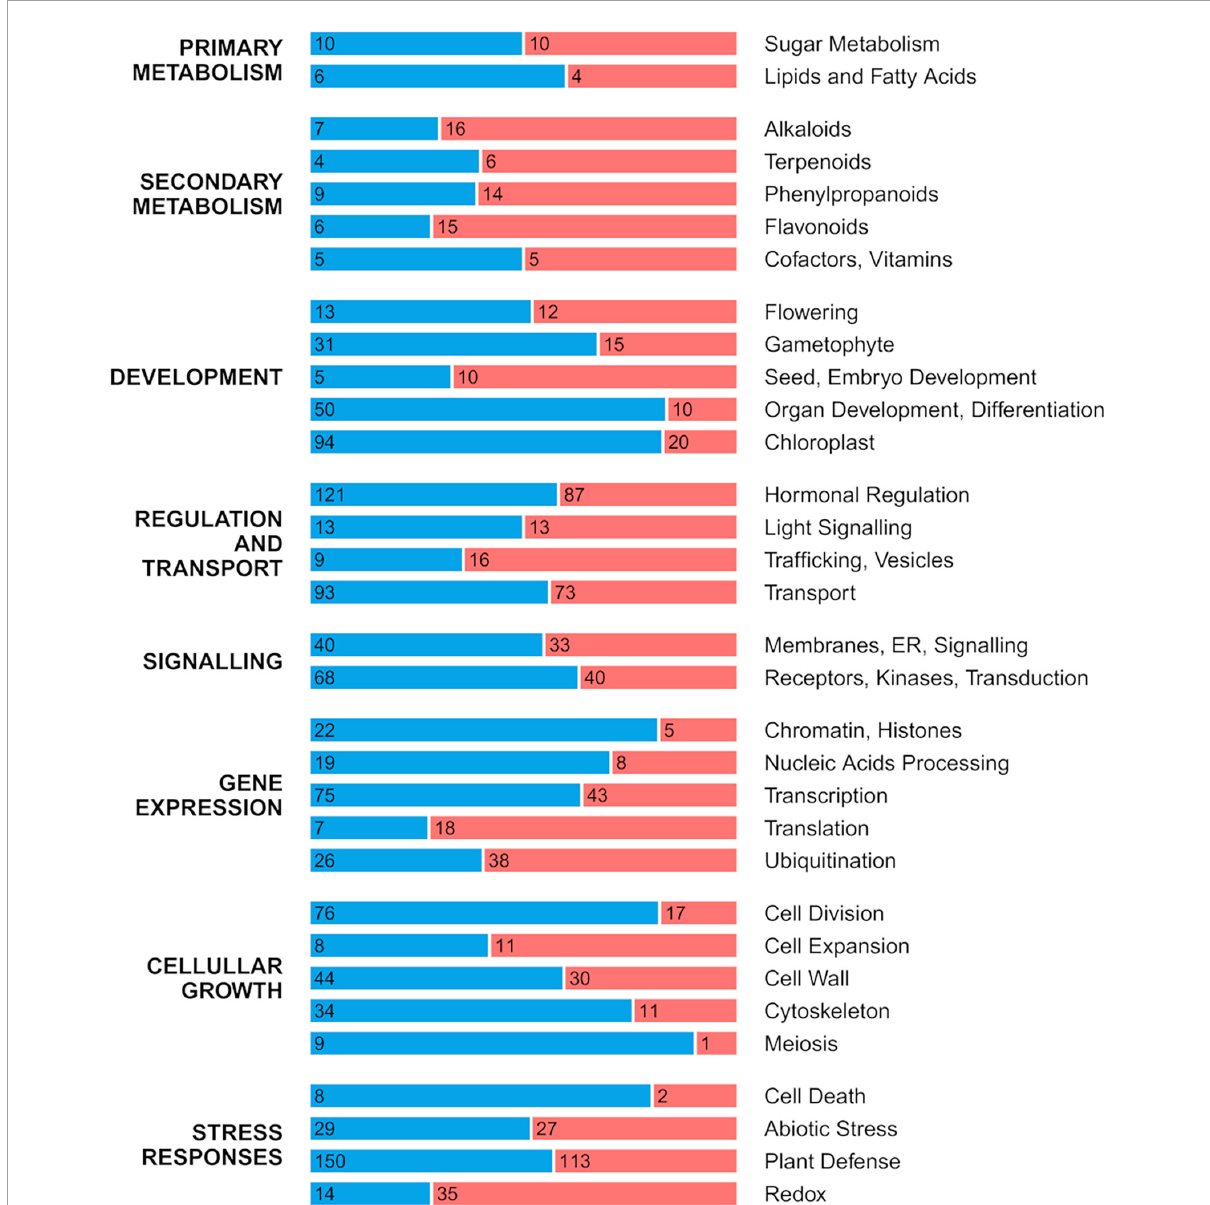
FIGURE1 Distribution of up- and downregulated DEGs in the pulp of developing fruitlets of ICH as related to SCM. DEGs were manually classified into eight major groups that were subsequently split in 32 gene categories corresponding to the most populated categories presented in Supplementary Table 3 , excluding the group of uncharacterized genes. Length of red and blue stretches represents the frequency of up- and downregulated genes, respectively, while numbers refer to the number of genes included in each category.